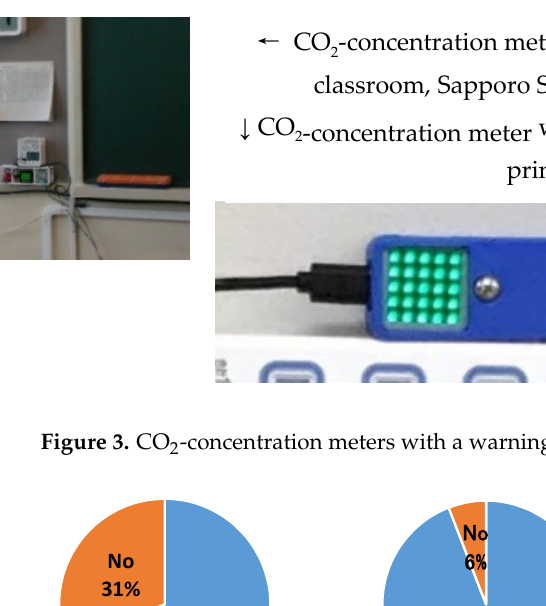
Figure 3. CO 2 -concentration meters with a warning display.